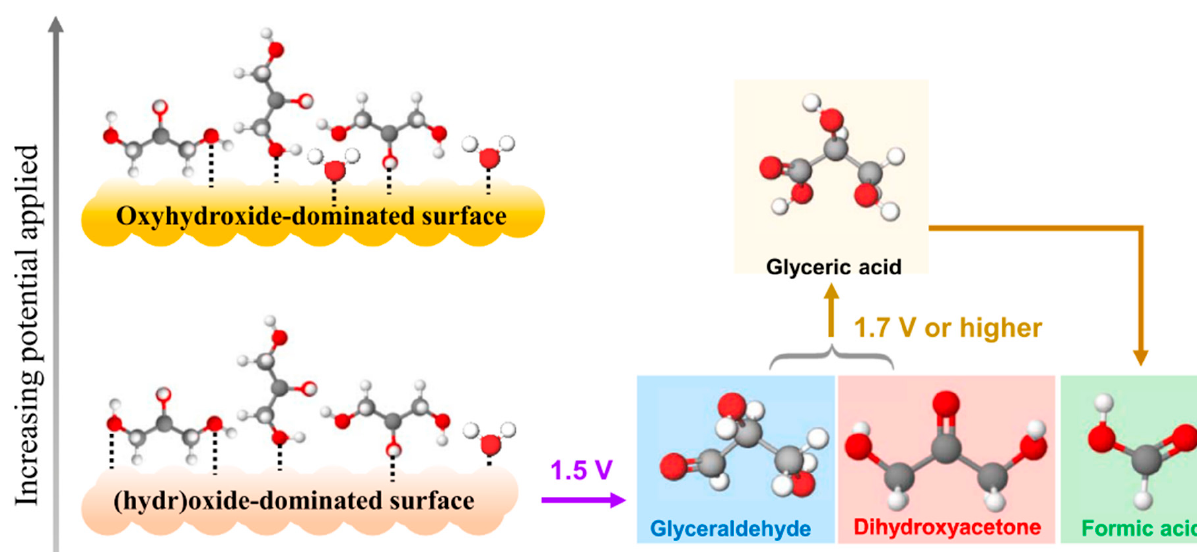
Figure 14. Proposed glycerol oxidation pathway over CoO x in mild alkali media. Reprinted with permission from Ref. [84]. Copyright 2021, Applied Catalysis B: Environmental.